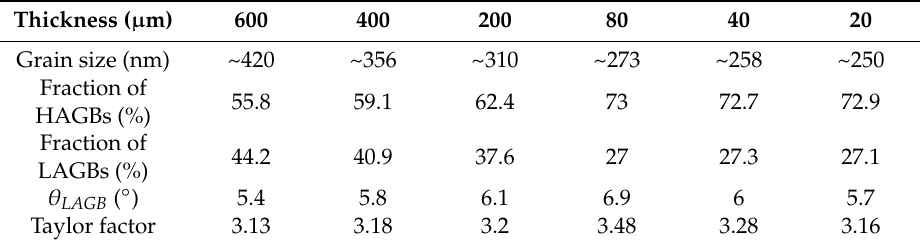
Table 2. Data for rolled pure Cu without intermediate annealing.